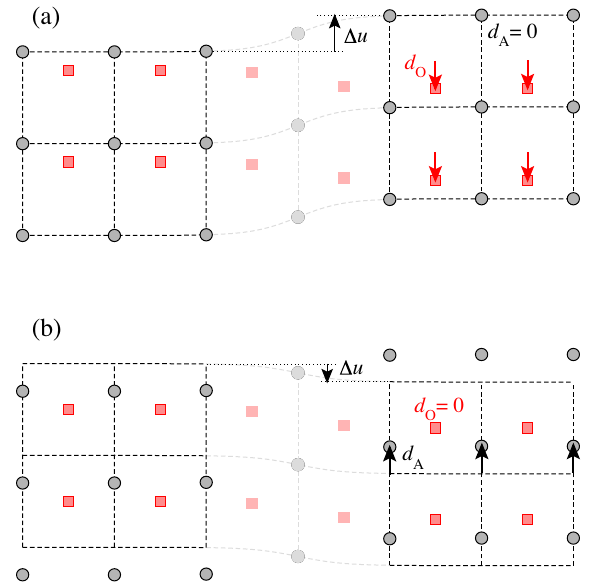
FIG. 1. Schematic model of a [100]-oriented ferroelectric domain wall in a perovskite crystal. For simplicity, only atoms in AO planes perpendicular to the wall are shown as red circles (A) and black squares (O), respectively. The elastic displacement of the crystal cells (dashed lines) is also shown. The ferroelectric distortion of the lattice deep within the domain is indicated by red and black arrows, respectively, for the displacements ( d κ ) of the A and O sublattice with respect to their high-symmetry positions. The macroscopic shift of the crystal cell Δ u is also shown. Displacements are exaggerated for illustration purposes. Panels (a) and (b) illustrate how two different choices for d κ and Δ u can be made for the same atomic